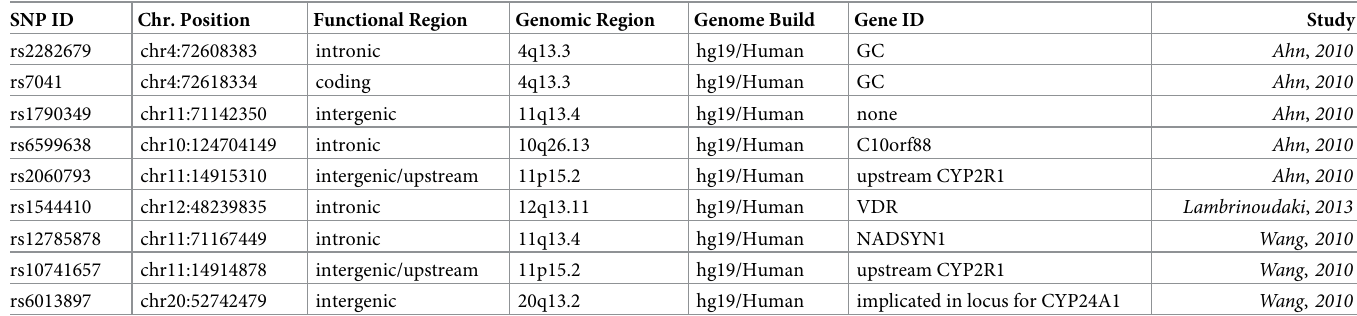
Table 1. Description of single-nucleotide polymorphism (SNP) markers.